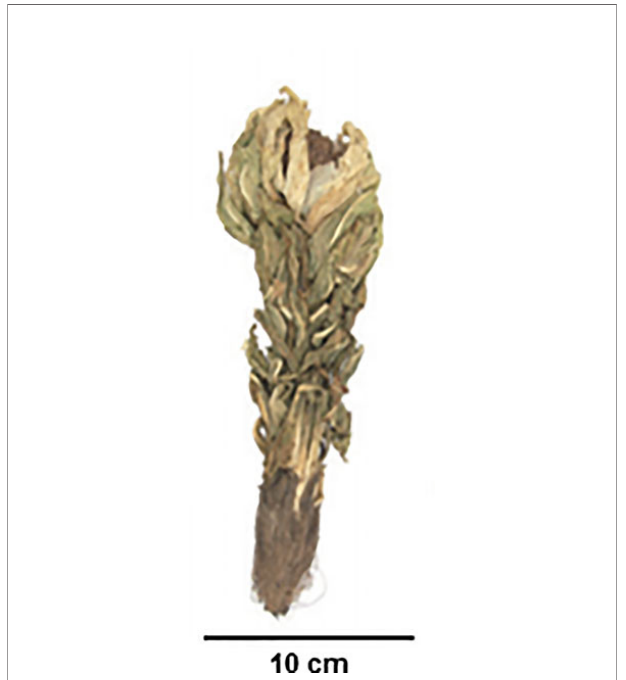
FIGURE 1 | The pictures of Snow lotus. Saussureae Involucratae Herba is described in the HKCMMS Volume 8.